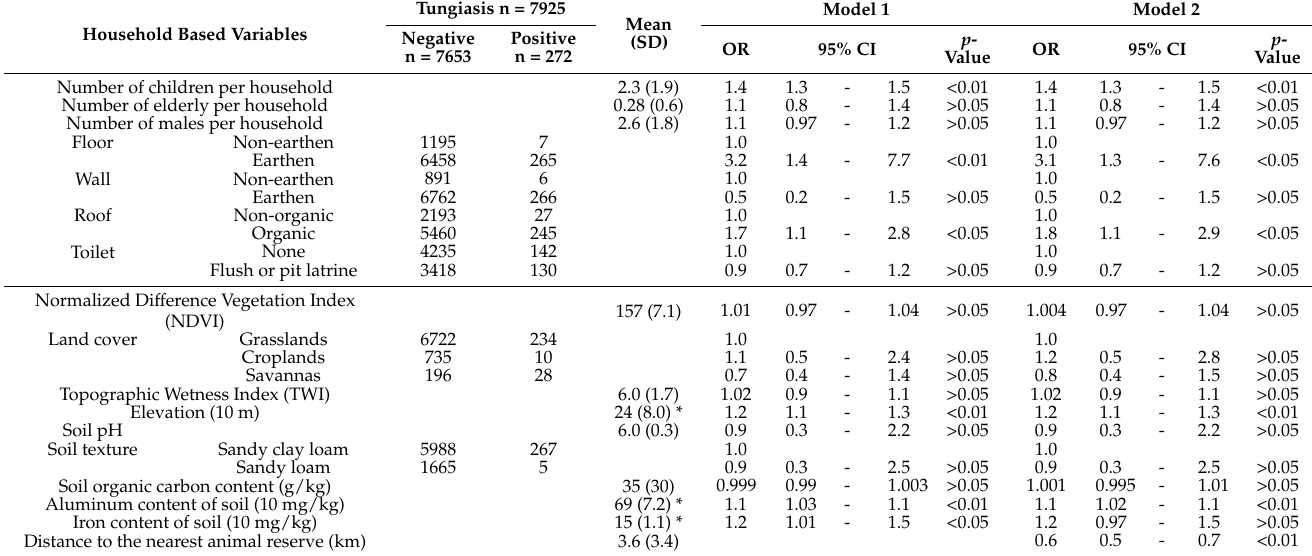
Model 1: a generalized additive model adjusted for the number of children per household, the number of elderly per household, the number of males per household, type of floor, type of wall, type of roof, type of toilet, NDVI, land cover, TWI, elevation, soil pH, soil texture, soil organic carbon content, aluminum content in the soil, and iron content in the soil; Model 2: a generalized additive model additionally adjusted for the distance to the nearest animal reserve area; *: Note that the units of these variables are ten times larger than usual. Actual mean values are 240 m for elevation, 690 mg/kg for aluminum of soil, and 150 mg/kg for iron content of soil, as well as standard deviations; CI: confidence interval; OR: odds ratio; SD: standard